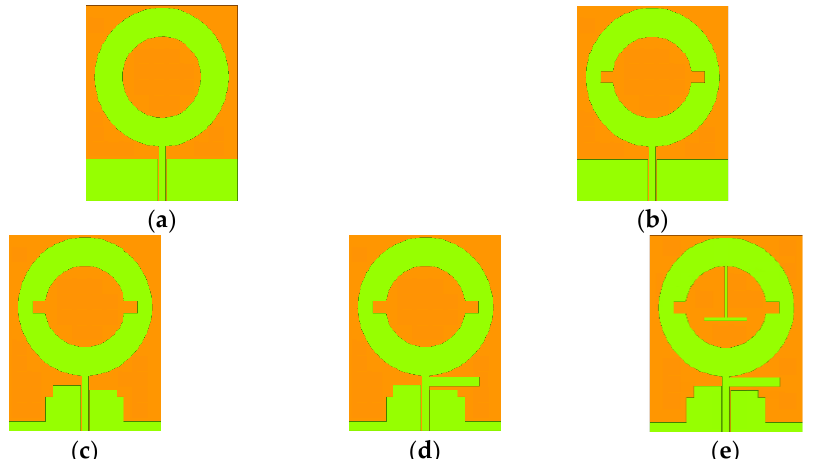
Figure 2. Step-by-step antenna design ( a ) antenna 1; ( b ) antenna 2; ( c ) antenna 3; ( d ) antenna 4; ( e ) antenna 5.